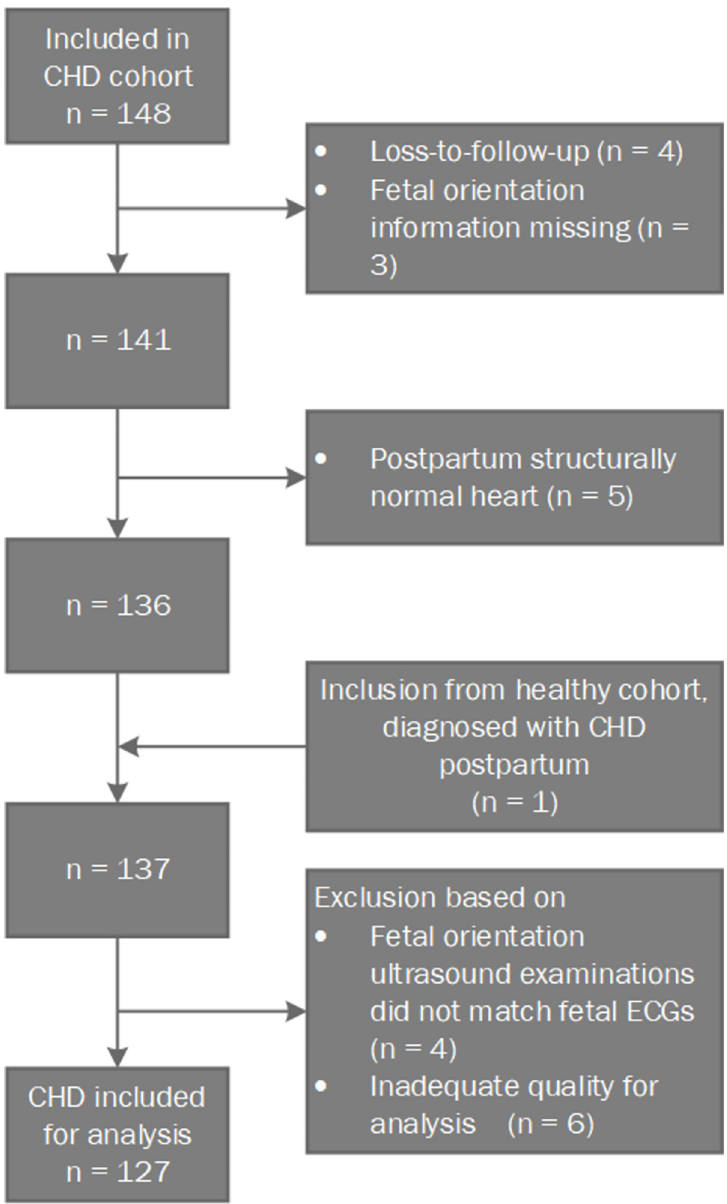
Fig 2. Flow diagram of patient